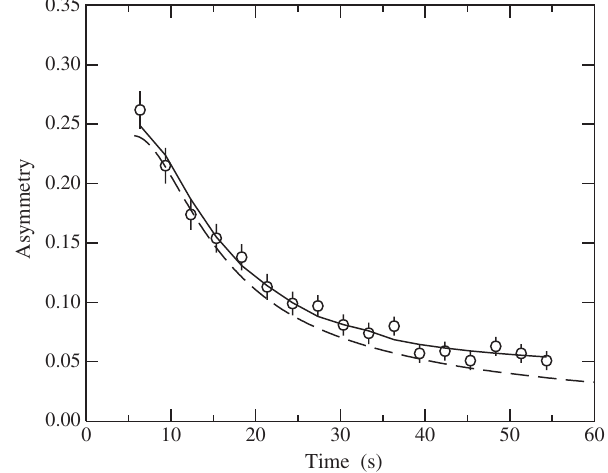
FIG. 13. Measurements of the time dependence of the hori- zontal magnitude [see Eq. (3)] compared with the best fit template curve (dashed line) and the template curve with the positive bias effects included (solid line). The modified curve is only defined where there are data points whose error determines the size of the positive